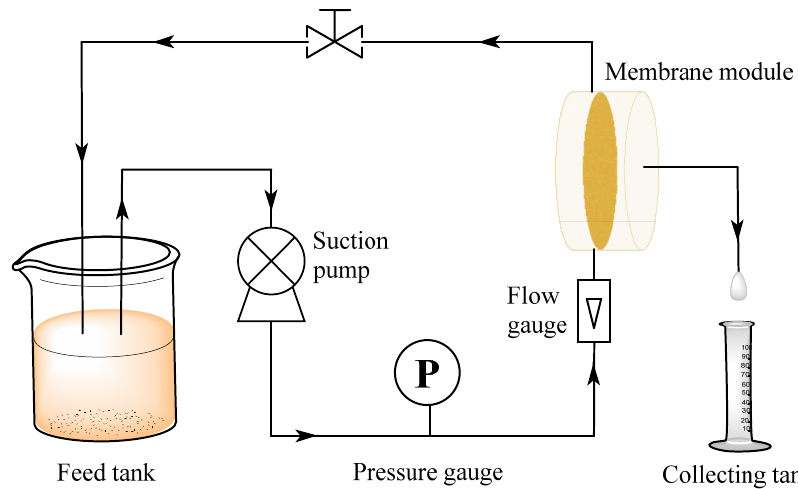
Figure 2. Scheme of laboratory homemade cross-flow filtration